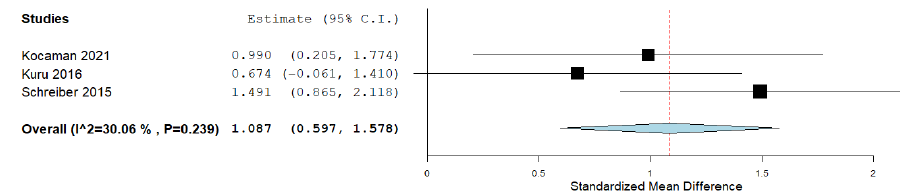
Figure 8. Effect size for the outcome